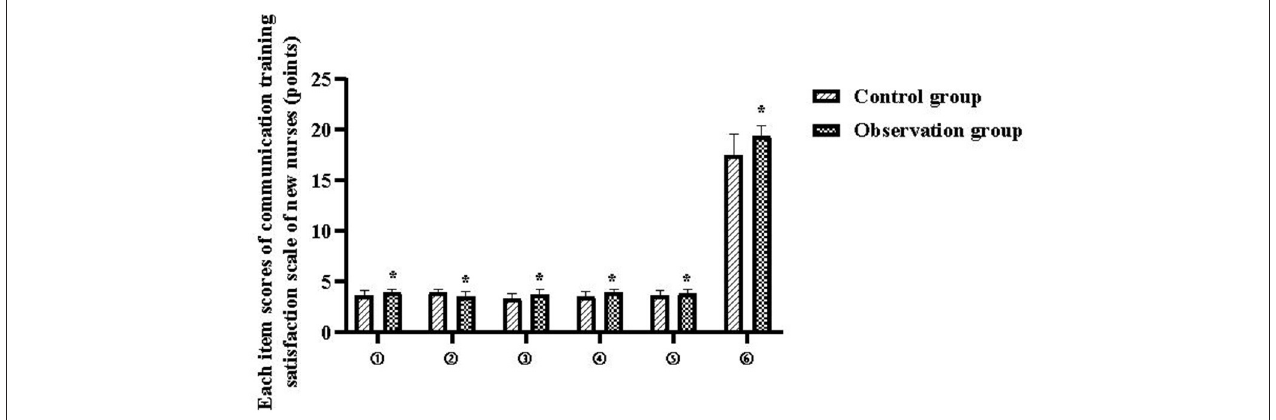
FIGURE 4 | Each item scores of communication training satisfaction scale of new nurses. Compared with the control group, * P <